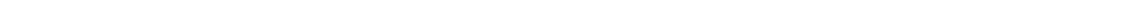
Upper: Representative images of HUVEC tube formation assay. Lower: Quanti fi cation of the percentage change of the number of branching points. Bar, 100 μ m. n = 3 per group, all experiments were repeated three times. Error bar indicates SD of the mean. * P < 0.05 versus untreated control using